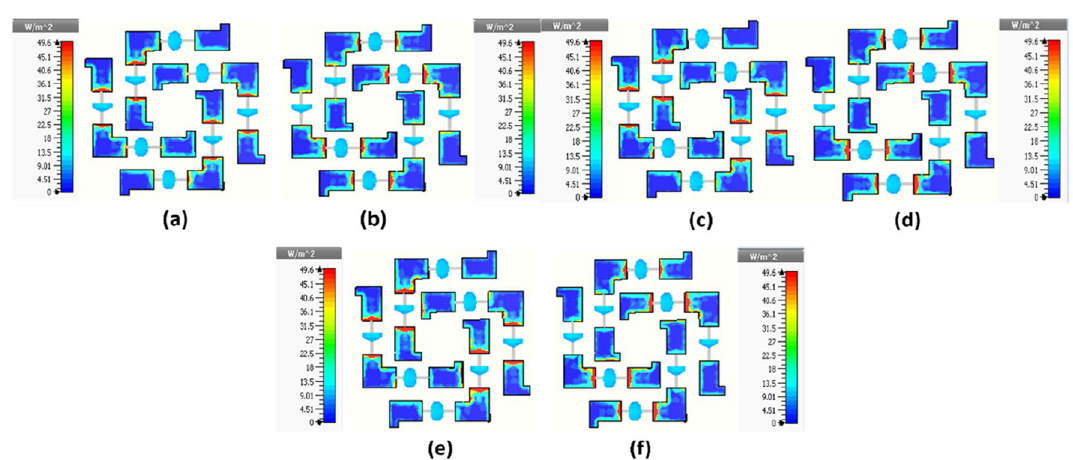
Figure 4. Power loss density distribution at ( a ) 14.84 GHz, ( c ) 17.99 GHz, ( e ) 21.14 GHz for TE- polarized incidence, and power loss density distribution at ( b ) 14.84 GHz, ( d ) 17.99 GHz, ( f ) 21.14 GHz for TM polarized